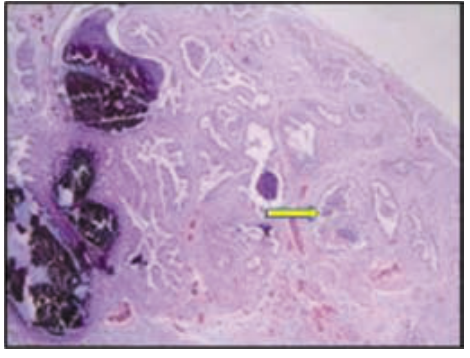
Fig. 3 . Basophilic amorphous granular liths in multiple efferent ductules and sperm stasis in dilated rete testis (arrow) (H&E x 100)